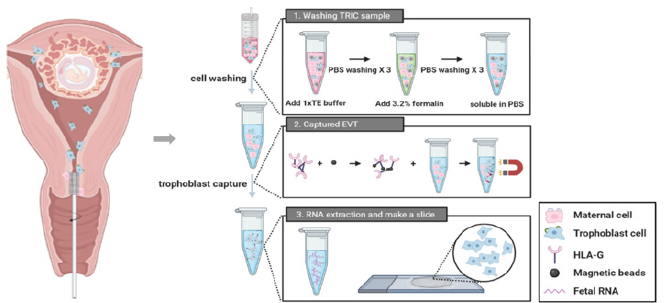
Figure 1. A procedure of trophoblast retrieval and isolation from the cervix